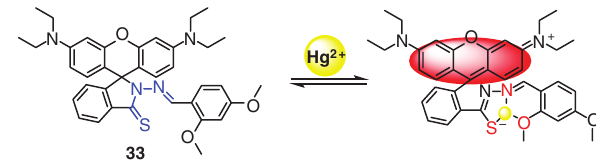
Figure 21: Recognition mechanism of probe 33 with Hg 2 + .